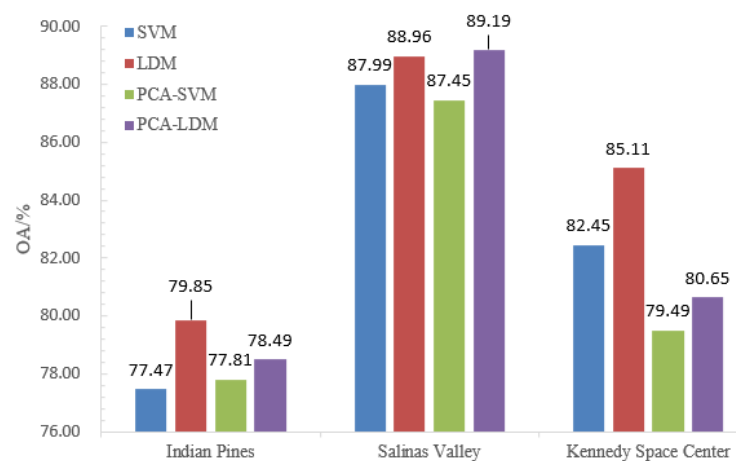
Figure 11. Comparison of SVM, LDM, PCA-SVM and PCA-LDM on three datasets.